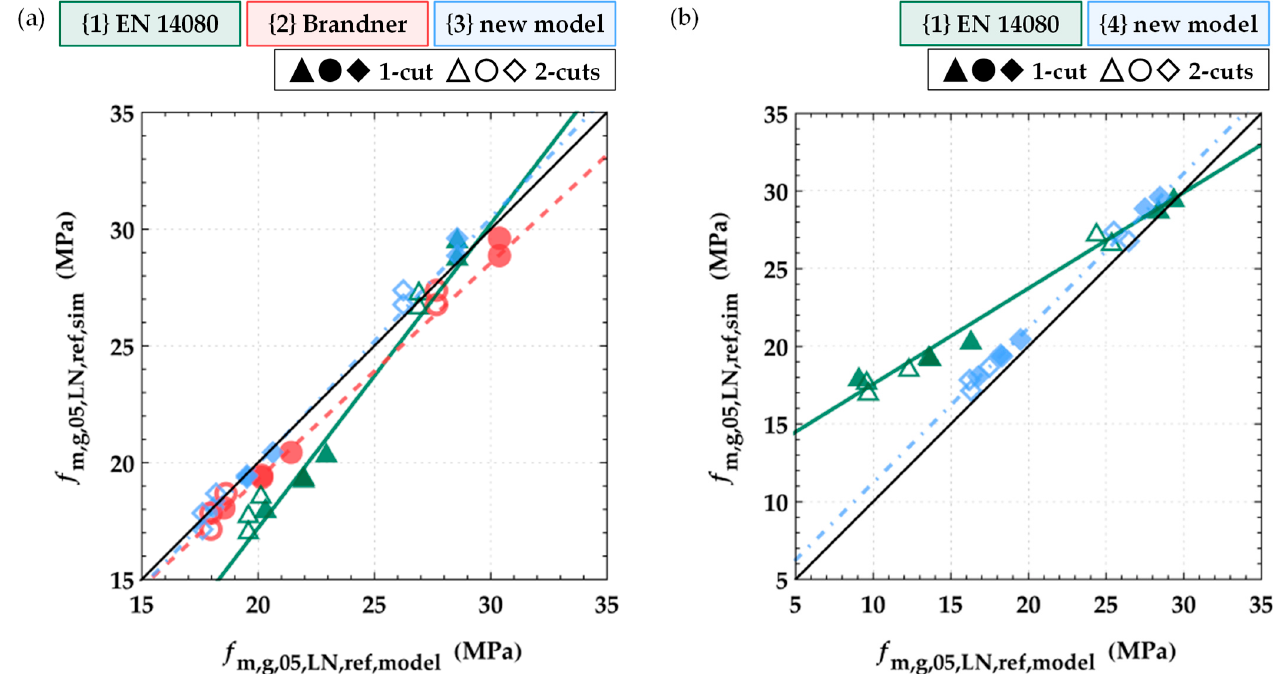
Figure 25. ( a ) Results of simulated characteristic (5%-quantile) bending strength values ( h g, ref = 600 mm) vs. the characteristic (5%-quantile) bending strengths according to the load bearing model in EN 14080 [10] {1}, Brandner and Schickhofer [34] {2} and Equation (11) {3} based on the characteristic (5%-quantile) tensile strength parallel to the grain of full and split boards with l b,ref = 2 m; ( b ) results of simulated characteristic (5%-quantile) bending strength values for split glulam beams ( h g, ref = 600 mm) vs. the characteristic (5%-quantile) bending strengths according to the model for resawn